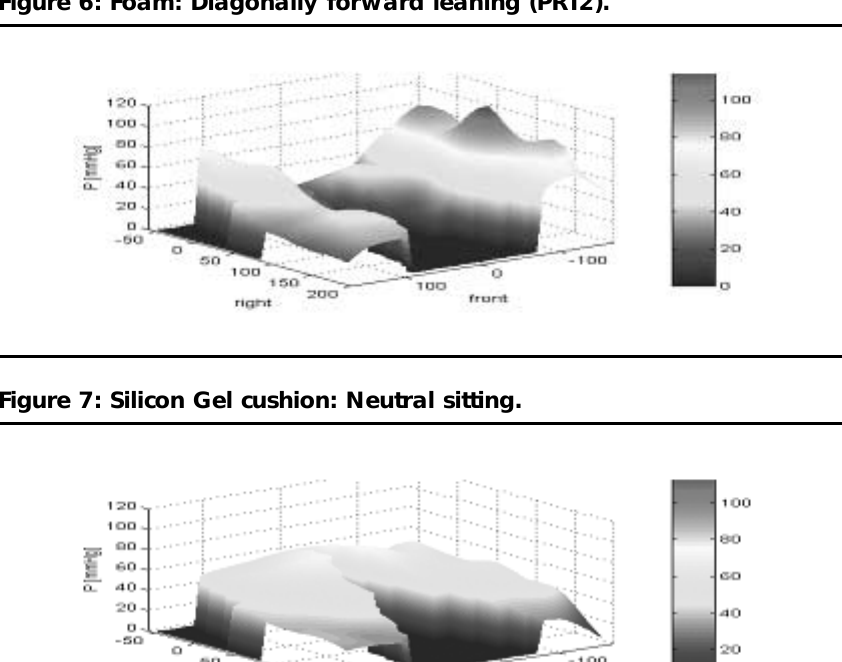
Figure 6: Foam: Diagonally forward leaning (PRT2).